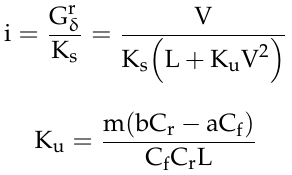
Z ∞ Z 2 Figure 5. Principle of H 2 /H ∞ hybrid robust control. (1) Sensitivity and complementary sensitivity function The H 2 /H ∞ hybrid robust control strategy ensures the robust stability of the control system by controlling the actual yaw velocity tracking ideal value. The disturbance inputs